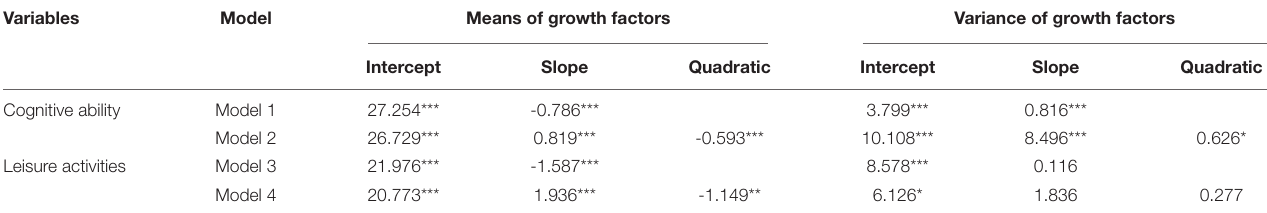
TABLE 4 | Parameter Estimates of latent growth models for leisure activities and cognitive ability.